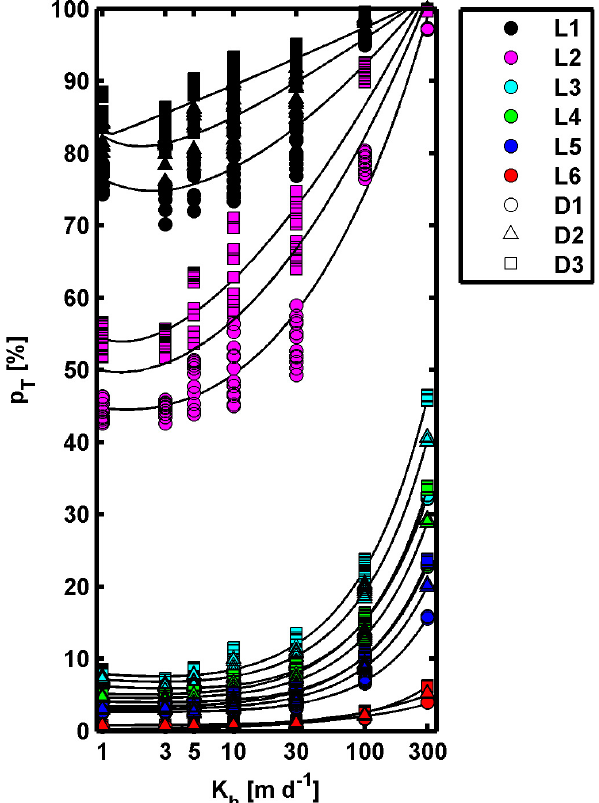
Fig. 5. Resulting intersection probabilities depending on K h on a logarithmic scale for all analyzed aquifer and septic system con- figurations. The color of the markers indicates the various lot sizes (L1–L6; see text for further specifications). The form of the mark- ers indicates the three drainfield sizes. The range of p T for a given K h , lot and drainfield size stems from the variation of K g and – to a much smaller extent – of K v (see Fig. 6). The black lines correspond to the exponential fits (Eq. 10) presented in Table